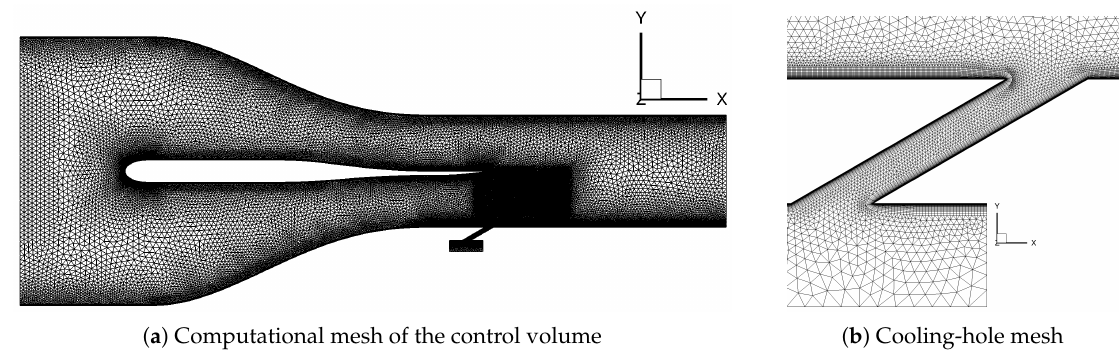
Figure 3. Computational